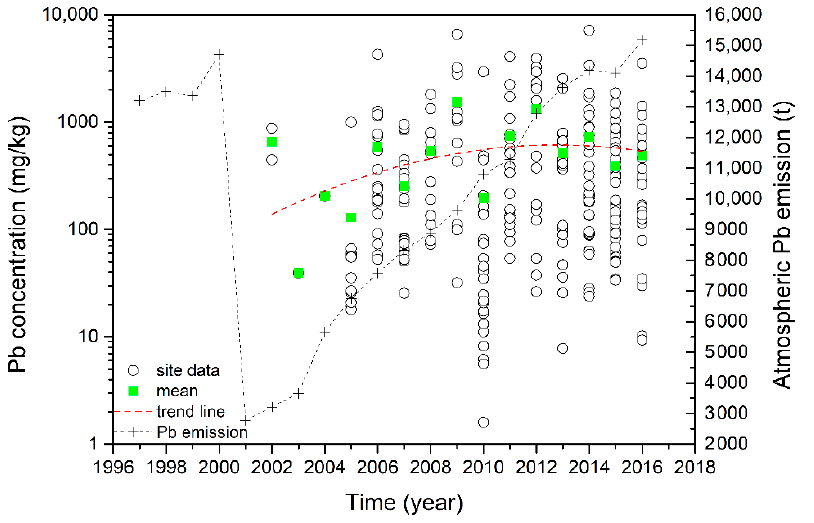
Figure 3. Temporal trend in Pb concentration (mg/kg) in soils in mining areas and annual atmos ‐ pheric emissions of Pb (t).